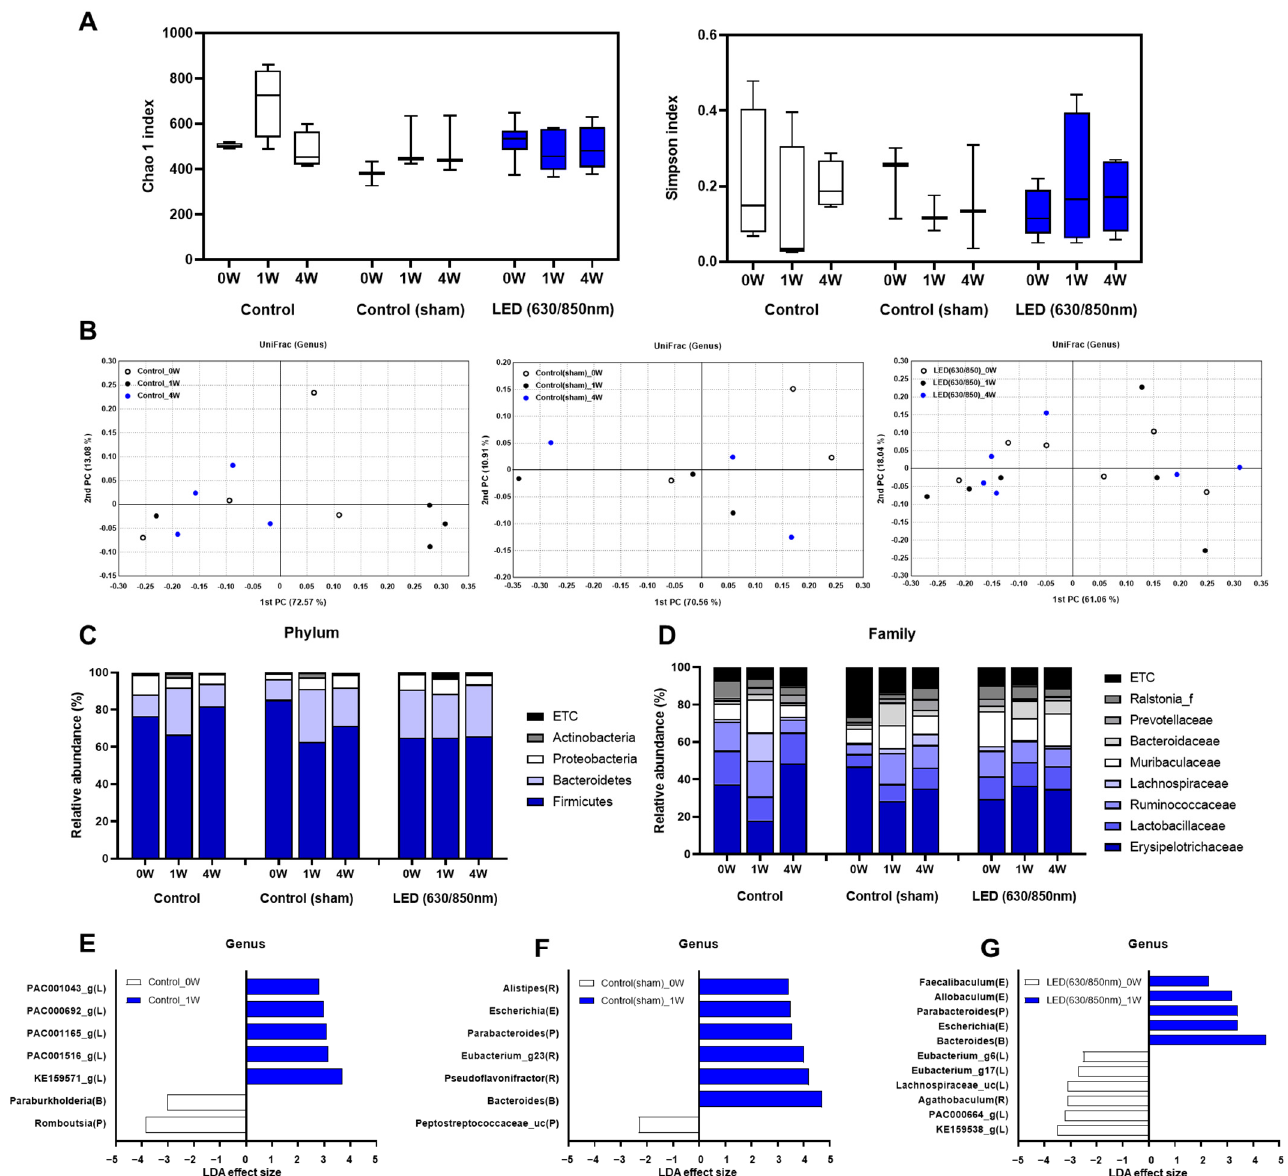
Figure 5. Comparison of gut microbiome after duodenal dual-wavelength photobiomodulation (D-PBM) using micro-LED in Goto–Kakizaki (GK) rats. ( A ) Chao1 index and Simpson index reflecting